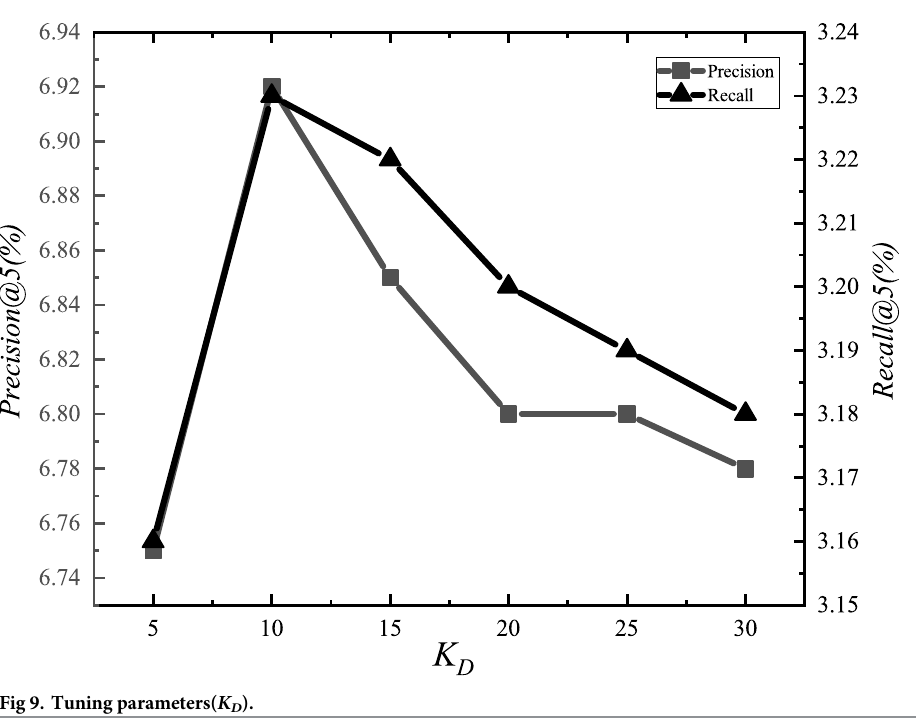
Fig 9. Tuning parameters( K D ).